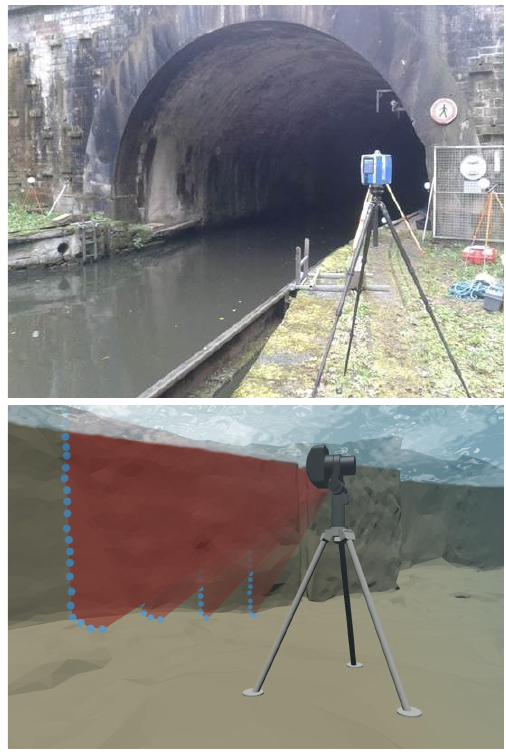
Figure 2: Data acquisitions in Niderviller’s tunnel : photograph of TLS device and spherical targets (top); schematic representa- tion of MSS devices (bottom) TLS surveying of the whole tunnel. To register point clouds, spherical targets have been placed in the shared scanning area, as shown in Fig. 2 (top). In order to geo-reference the model, the coordinates of sphere centers have been determined with tradi- tional surveying methods based on a set of points known in the French reference coordinate system (RGF 93 and NGF-IGN